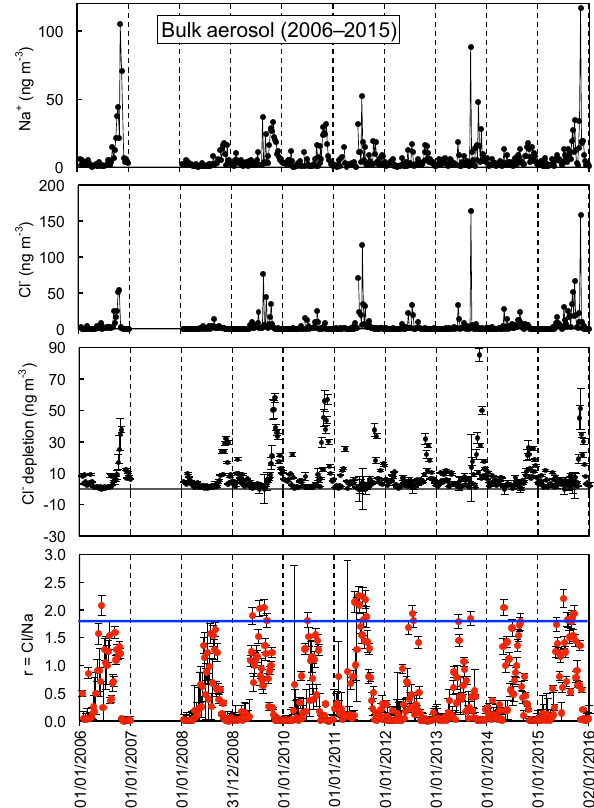
Figure 2. Weekly bulk aerosol concentrations of sodium and chlo- ride and the calculated chloride depletion relative to sodium with respect to the composition of freshly emitted sea-salt aerosol (Eq. 2) and the mass Cl / Na ratio ( r ). Vertical bars refer to uncertainty in calculating r (Eq. 1) and the chloride depletion value (Eqs. 3 and 4). The horizontal blue line refers to the r seawater reference value (1.8).